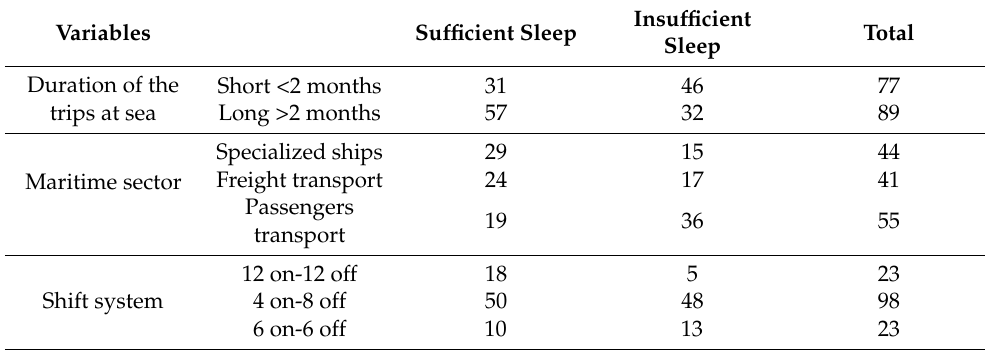
Table 1. Distribution of the responses for the variable “sleep requirements” for the duration of embarkation, the maritime sector, and the watch system.